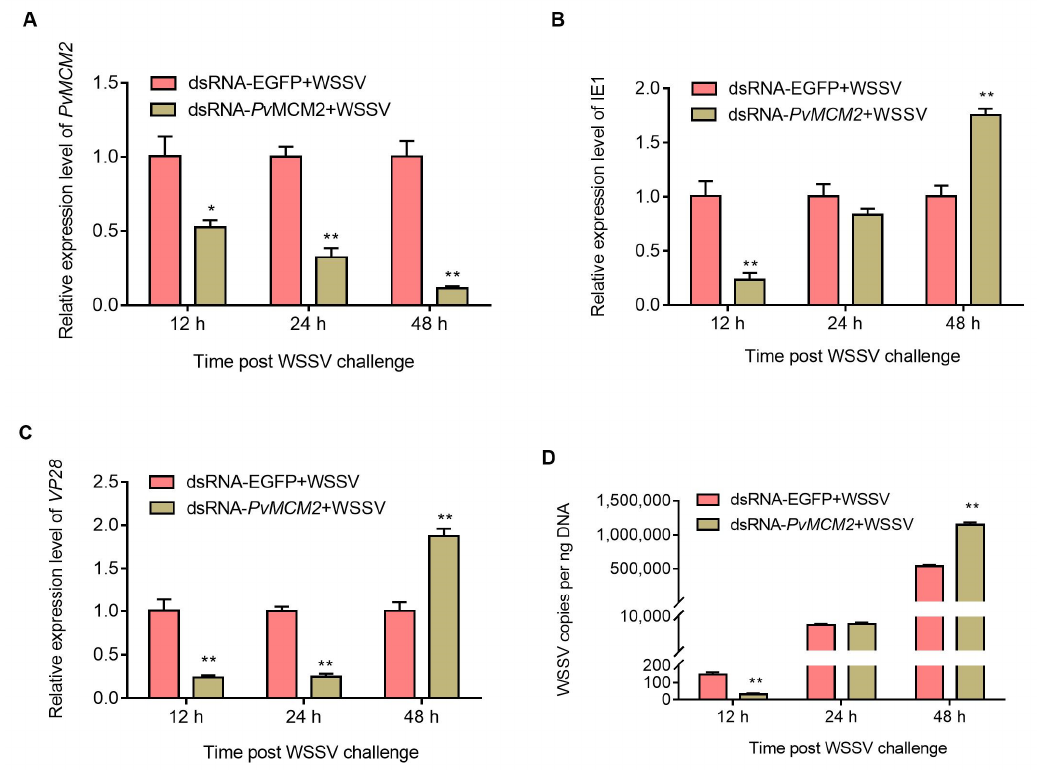
Figure 7. Pv MCM2 knockdown inhibits WSSV replication at the early infection stage. ( A ) Knock- down efficiency analysis of Pv MCM2. ( B – D ) qPCR analysis of WSSV genes’ expression (IE1 and VP28) and viral loads after Pv MCM2 knockdown. Shrimp were separately injected twice with dsRNA- Pv MCM2 and dsRNA-EGFP (negative control), followed by WSSV infection. At 12, 24, and 48 h post viral infection, hemocytes were collected and used to detect the knockdown efficiency of Pv MCM2, expression of WSSV genes, and viral loads using qPCR analysis. For each sample, tripli- cate qPCR assays were performed, and the data were shown as mean ± SD. Significant differences were computed using the Student ’ s t -test (* indicates p < 0.05, and ** indicates p < 0.01). 2.6. IE1 Promotes the Cellular DNA Synthesis In Vitro Until now, there was no available shrimp cell line for plasmid transfections. Hence, in this study, the High-Five cell, a clonal isolate derived from the parental Trichoplusia ni (cabbage looper ovary), was used to determine whether IE1 could modulate DNA repli- cation. First, we transfected the IE1 expression plasmid (pIZ-V5-IE1) and empty vector (pIZ-V5-His) into the High-Five cells and then determined the expression of MCM com- plex genes and DNA synthesis. As illustrated in Figure 8A, IE1 could be expressed in High-Five cells at 24 h post transfection. Following this, the pIZ-V5-IE1 and pIZ-V5-His transfected cells were harvested and used for qPCR and DNA synthesis analysis. The qPCR result showed that the mRNA expression of MCM complex genes in High-Five cells were generally upregulated after IE1 overexpression compared to the control (Figure 8B). Furthermore, the EdU-positive cells were increased by about 14% after IE1 overexpression compared with the control (Figure 8C,D). This result suggests that IE1 could facilitate the cellular DNA synthesis via elevating the expression of the MCM complex genes in vitro.